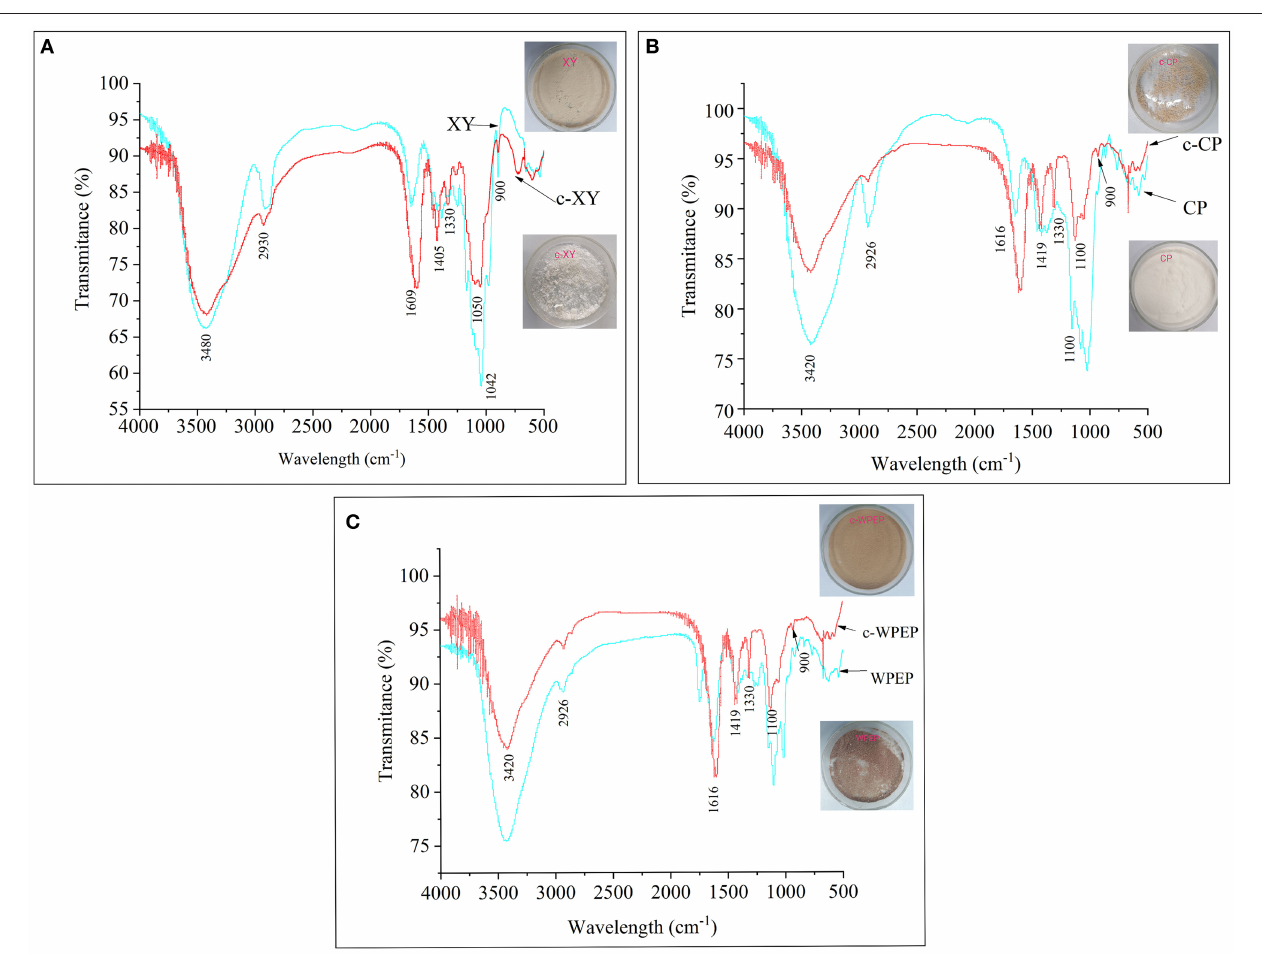
FIGURE 1 | FT-IR spectra of (A) xylan (XY), (B) citrus pectin (CP), and (C) crude water-soluble polysaccharides of Passiflora edulis peel (WPEP) samples.